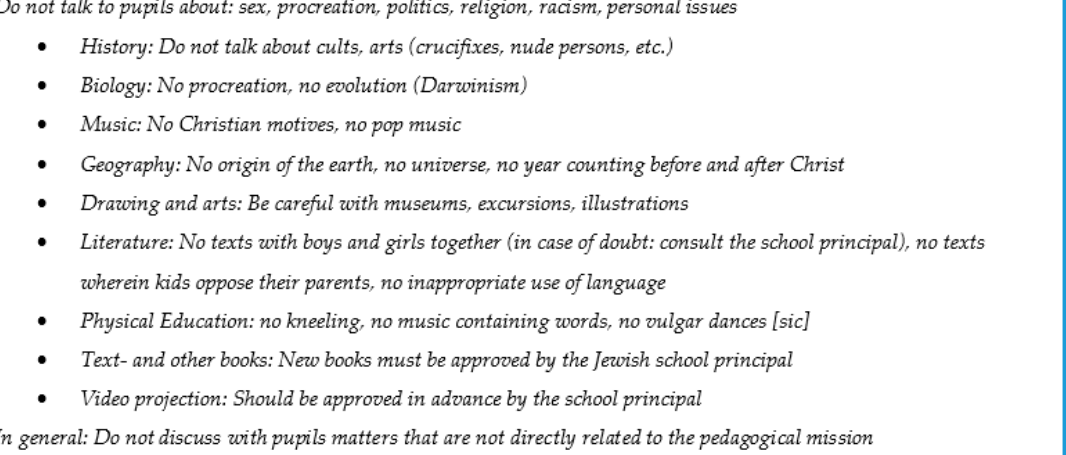
Figure 1. Extract from the document with guidelines from school Y .